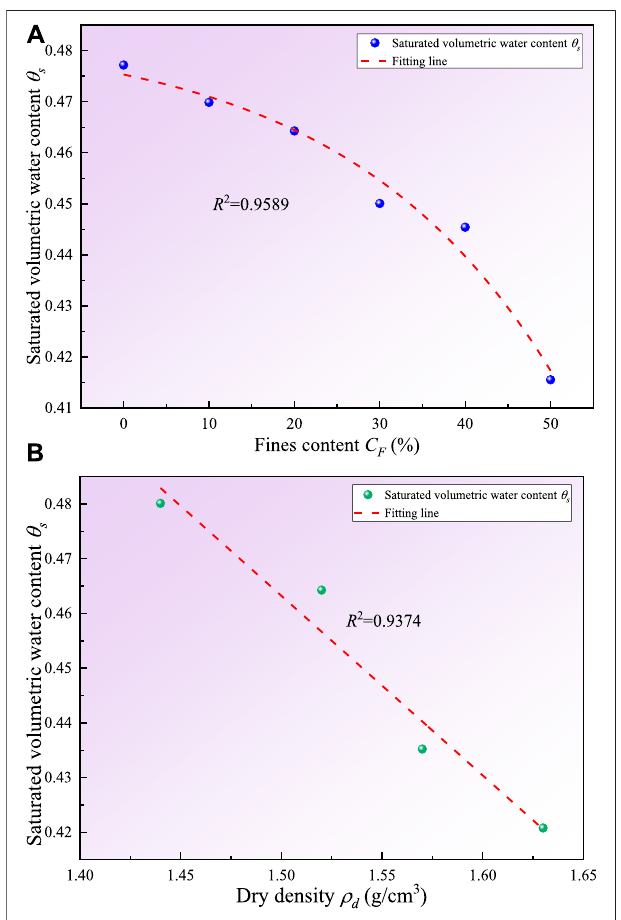
FIGURE 10 | The relationship among saturated volumetric water content, fi nes content and dry density: (A) saturated volumetric water content versus fi nes content; (B) saturated volumetric water content versus dry